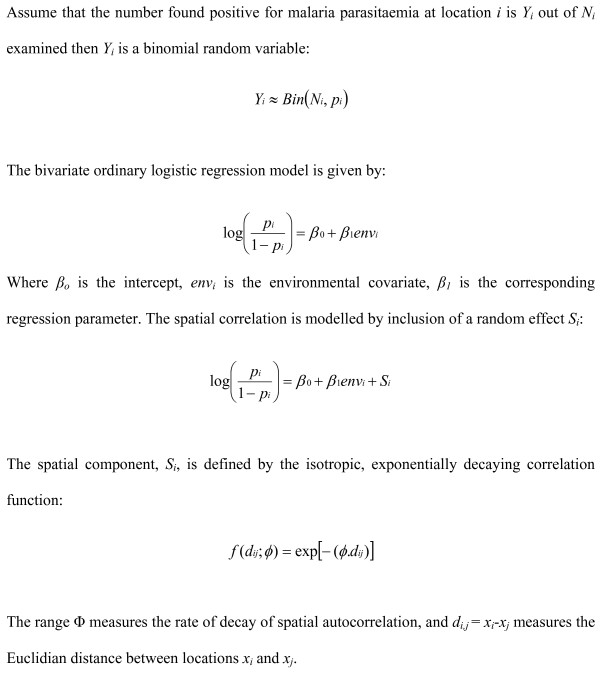
Spatial prediction model based on the principles of model-based geostatistics.